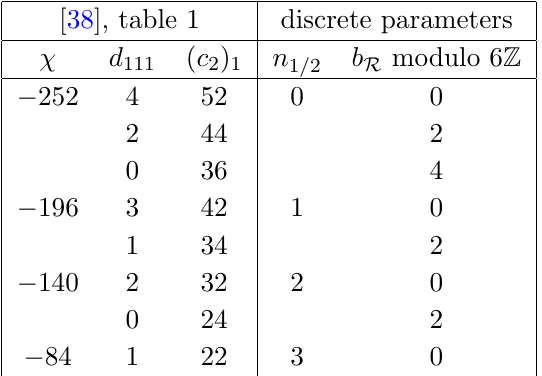
; b R + 6 Z ) of the modular forms (cid:8) and (cid:9) are 1 = 2